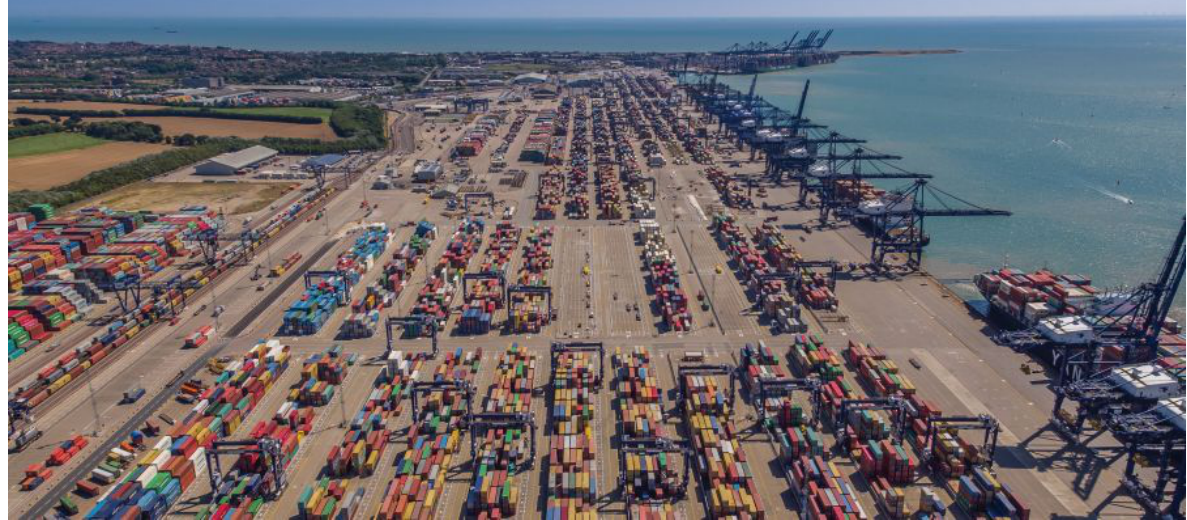
Figure 9. Grid layout of container stacks at Felixstowe Port, UK. Photograph reprinted, with permission, courtesy of the Port of Felixstowe. © 2021 Port of